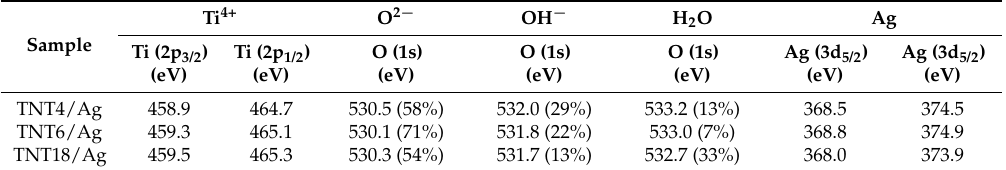
Table 1. X-ray photoelectron spectroscopy peak positions for TNT/Ag coatings (TiO 2 nanotubes were produced at 4 V (TNT4), 6 V (TNT6), and 18 V (TNT18)) on the surface of titanium foil (99.6% Ti, 0.20 mm thick, STREM).